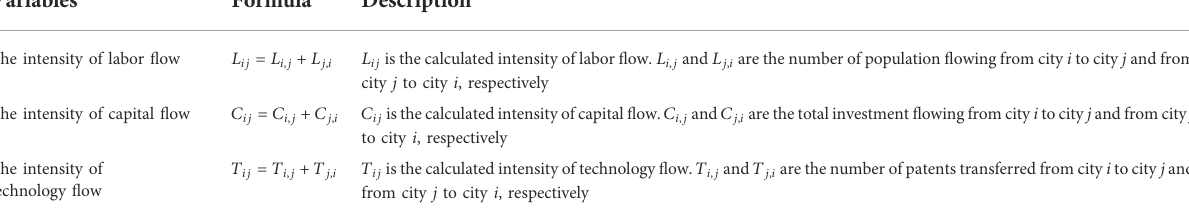
TABLE 1 Formulas for calculating the intensity of production factors fl ow.